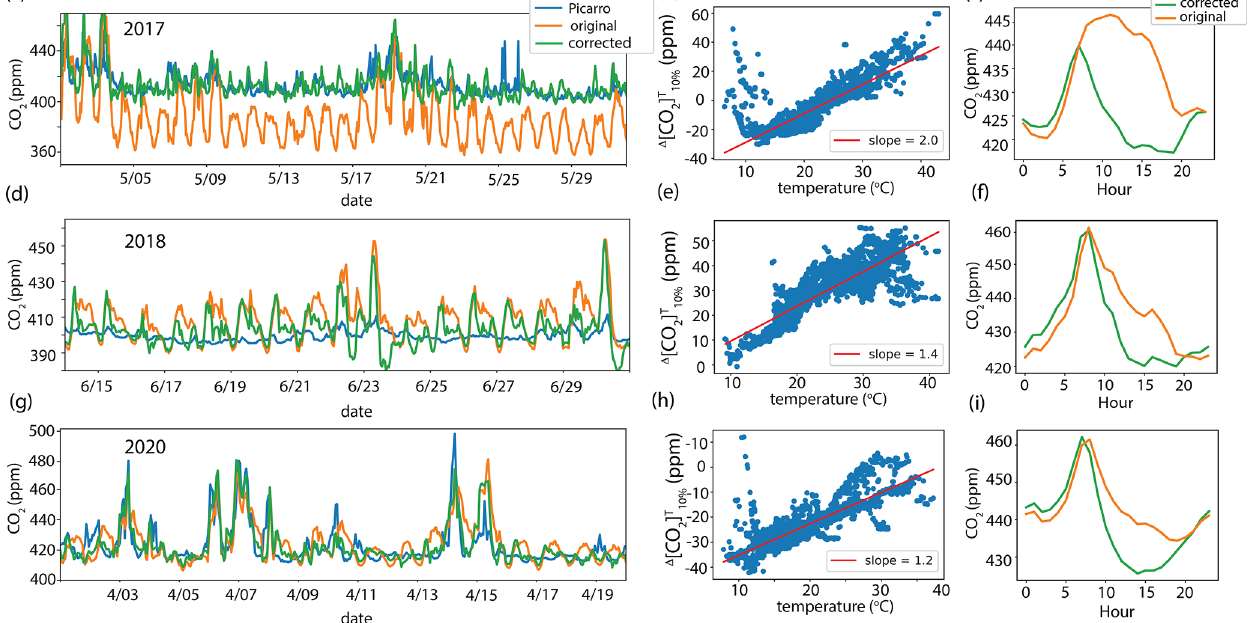
Figure 6. Data from 2017 are in top panels, 2018 are in middle panels, 2020 are in bottom panels. (a) CO 2 mixing ratios at Laney College with no temperature correction (green), temperature correction applied (blue), and measured with a Picarro instrument at the Richmond Field Station supersite (2018 and 2020) or with the Exploratorium Buoy (2017). (b) Temperature dependence at Laney College of (cid:49) [ CO 2 ] T (c) Laney College diurnal CO 2 cycle with (green) and without (orange) temperature